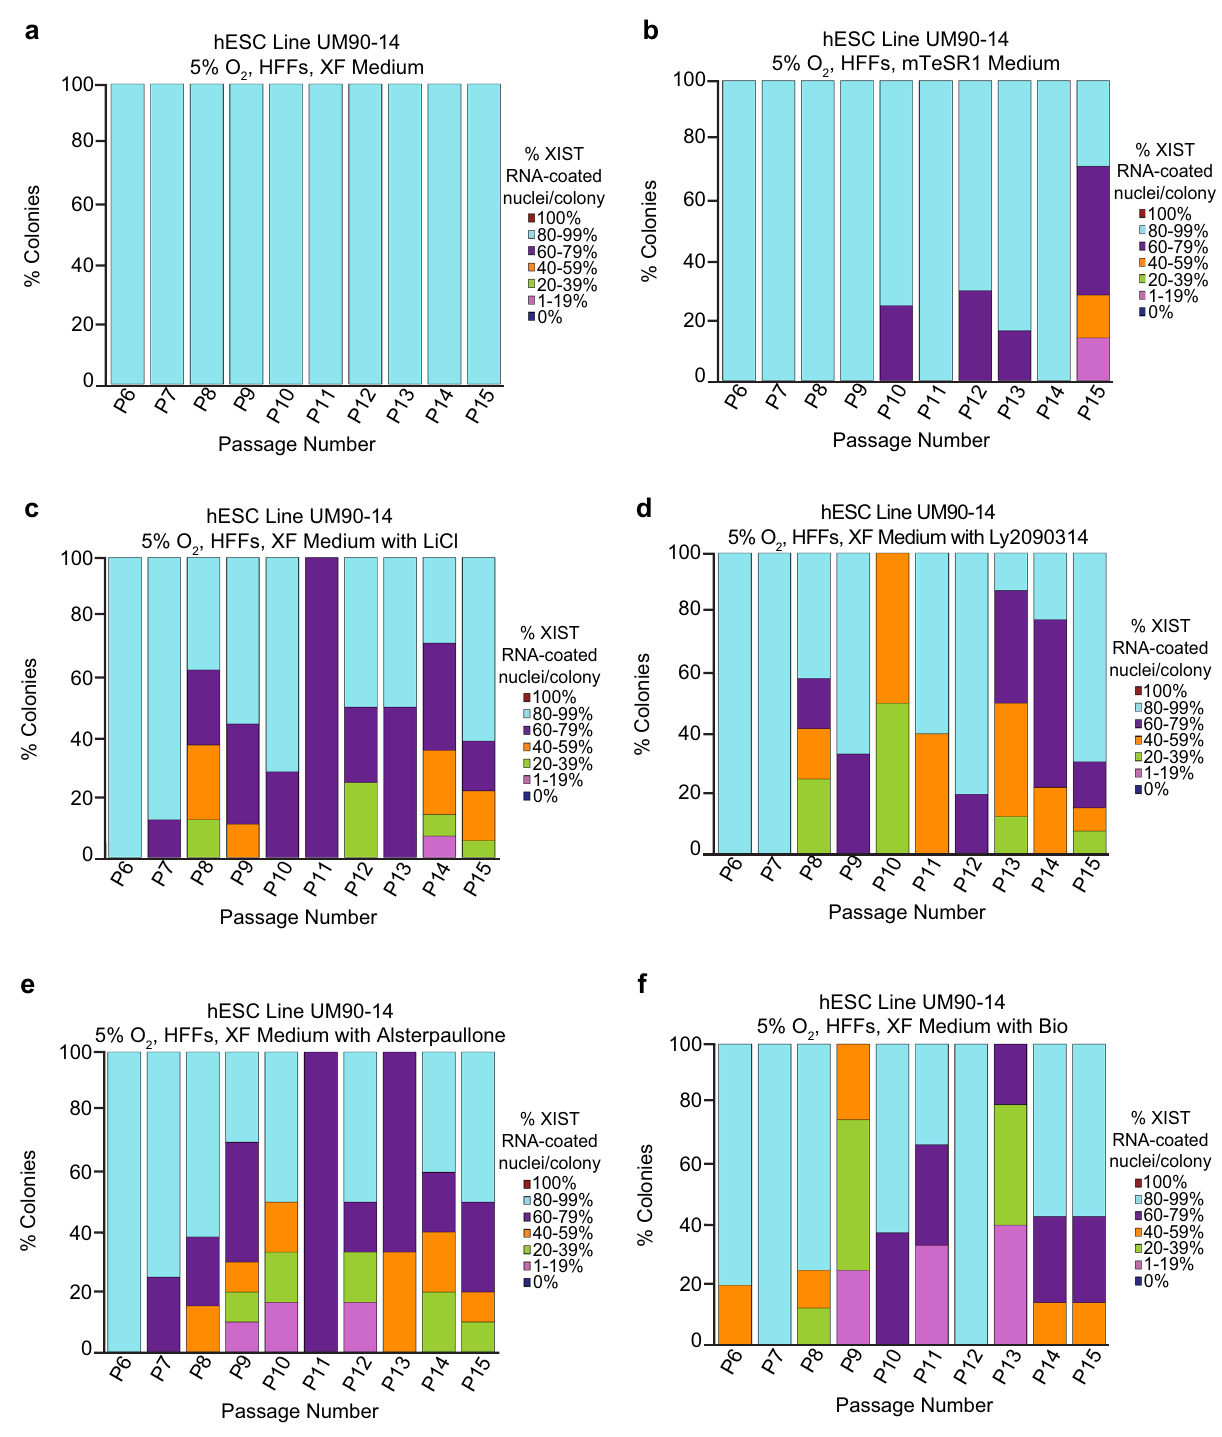
Fig. 8 GSK-3 Inhibition and Loss of XIST RNA Coating in Female hESCs. Percentage of nuclei with XIST RNA coating in colonies of hESC line UM90-14 cultured in XF medium ( a ); mTeSR1 medium ( b ); XF medium supplemented with 0.98 mM LiCl (XF with LiCl) ( c ); XF medium supplemented with 1.5 nM Ly2090314 (XF with Ly2090314) ( d ); XF medium supplemented with 5.0 nM Alsterpaullone (XF with Alsterpaullone) ( e ); and, XF medium supplemented with 5.0 nM BIO (XF with Bio) ( f ). hESCs cultured in mTeSR1, XF with LiCl, XF with Ly2090314, XF with Alsterpaullone, and XF with BIO media lost XIST RNA coating during passaging in a signi fi cant percentage of nuclei compared to hESCs cultured in XF medium (general linear model comparison, p < 0.001). All hESCs in this experiment were cultured in 5% O fi cation. 2 on HFFs. At least 100 nuclei were counted per colony for hESC RNA FISH quanti The total number of colonies quanti fi ed at each passage range between 1 and 18 and are cataloged in source data. Source data are provided as a Source Data fi